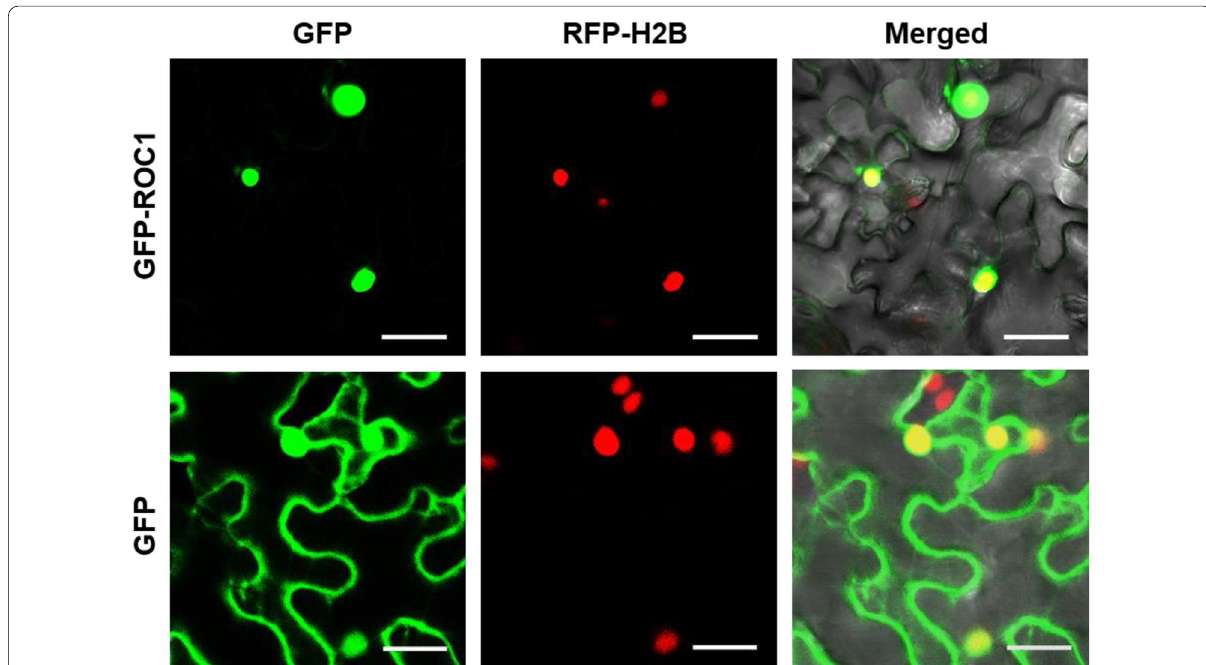
Fig. 4 Subcellular localization patterns of ROC1. GFP-ROC1 was expressed in RFP-H2B transgenic N. benthamiana leaves. The red fluorescence produced by RFP-H2B serves as a nuclear marker. Bar